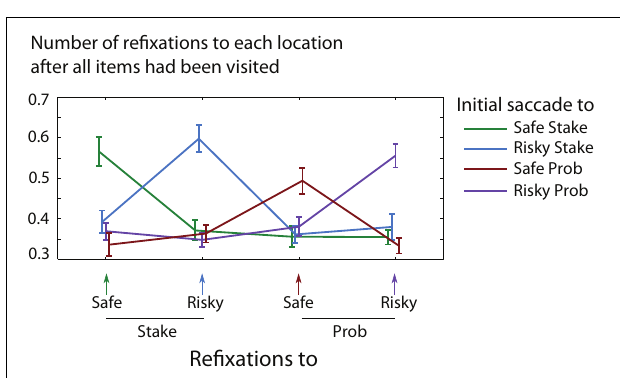
FIGURE 10 | The chance of refixating each displayed item. Line colour indicates which item was fixated first on a trial. Refixations are strongly drawn to the very first acquisition of the